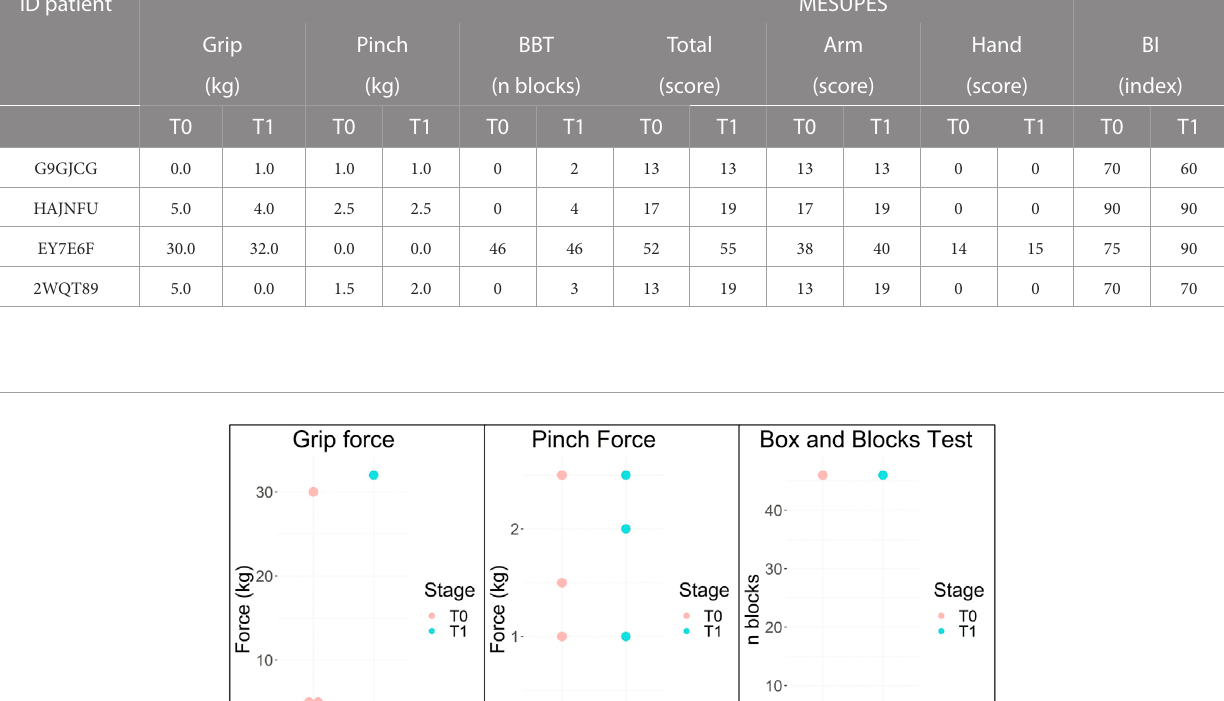
TABLE4 Baselineresults(T0)andpost-interventionresults(T1)oftheperformedmanualfunctiontests:grip,pinch,BBT,MESUPESandBI. ID patient